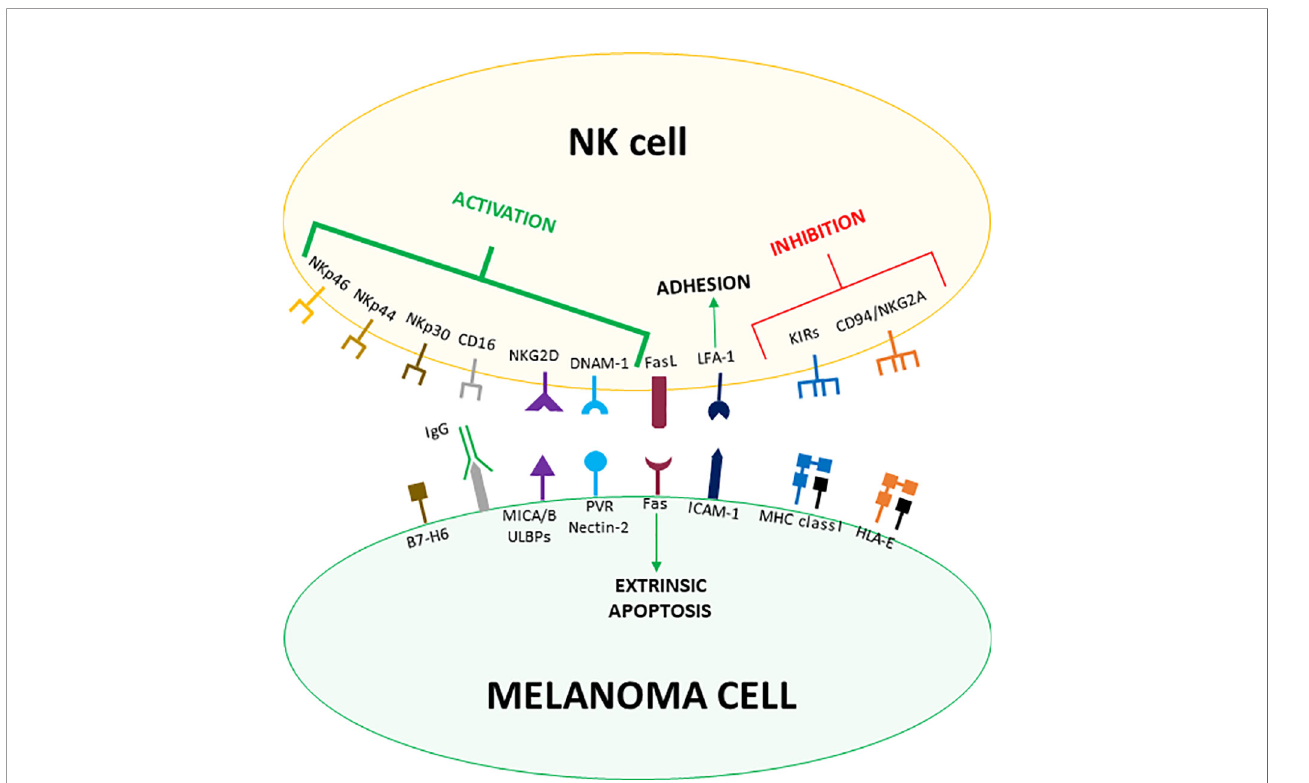
FIGURE 1 | Receptor-ligand pairs involved in melanoma cells recognition by NK cells. Both MHC class I and MHC-like HLA-E molecules expressed by melanoma cells counteract NK cells activation by engaging the inhibitory receptors KIRs and CD94/NKG2A, respectively. On the other hand, malignant transformation induces the expression of NKG2D, DNAM-1 and NCR-ligands on melanoma cells, which are recognized by the cognate activating receptors expressed on NK cells. Melanoma cells usually up-regulate the expression of activating ligands and down-regulate MHC class I molecules levels tipping the balance towards the activation of NK cells. Less speci fi c interactions such as LFA-1/ICAM-1 mediate the fi rm adhesion between NK and melanoma cells whereas Fas/FasL binding activates the extrinsic apoptosis. Moreover, CD16 contributes to melanoma cell killing by mediating